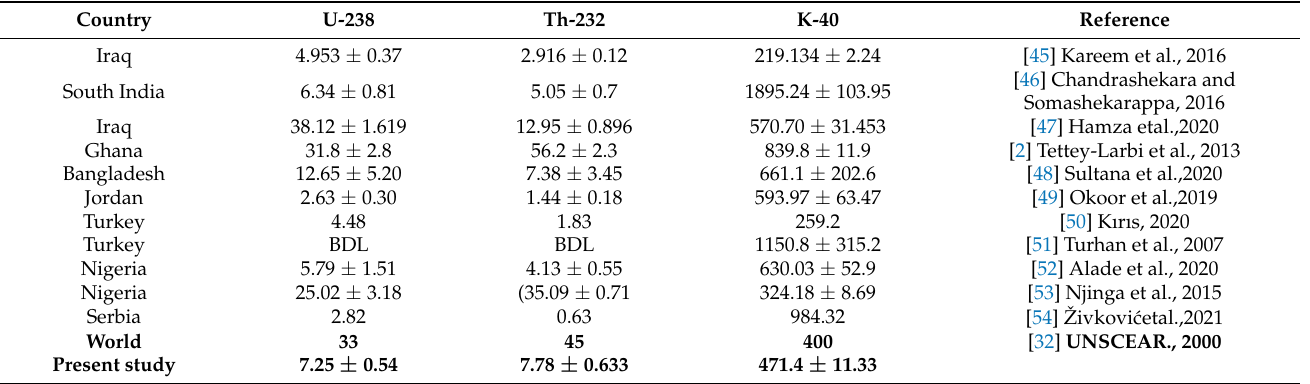
Table 3. The mean activity concentrations (Bq/Kg) of the natural radioactivity of medicinal plant samples in the present were compared with those from similar investigations performed in other